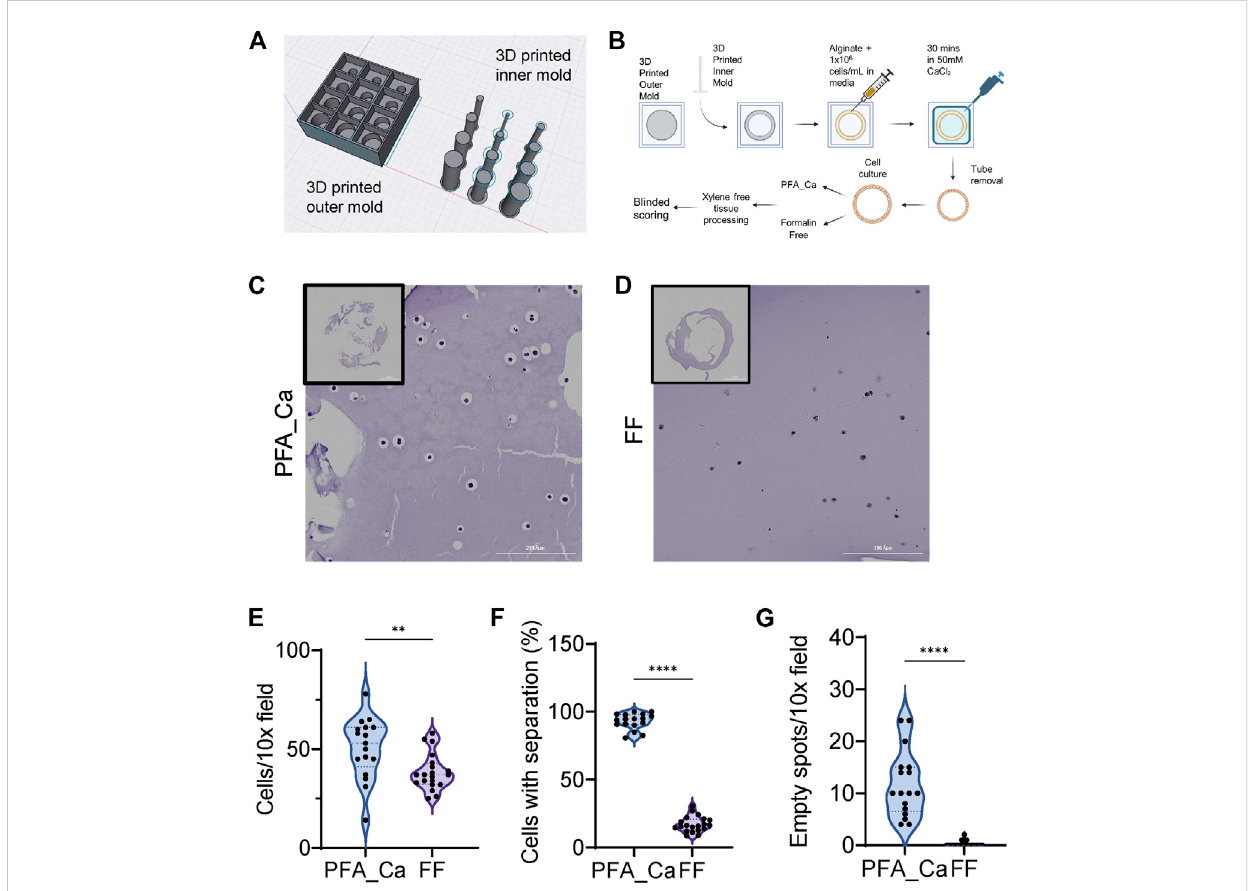
FIGURE 4 Fabrication of 3D alginate tubes containing cells using a two-part 3D printed PLA mold. (A) 3D printed mold for constructing calcium alginate tubes constructed in Sahpr3D. (B) 3D printed inner molds are placed inside the outer mold and lightly dipped in 50 mM calcium chloride solution. The inner portion of the mold is slowly fi lled with sodium alginate and cell solutions until it reaches the top of the depressed region of the mold. Next 50 mM calcium chloride solution is placed on the crosslinking reservoir above the tube and sodium alginate solutions containing cells are allowed to crosslinkfor30 min.Tubesarethencarefullyremovedandsubjectedtocellcultureovernightfollowedby fi xationinPFA_CaorFFandprocessed usinga xylene free tissue processing routine. H&E sections were then blindly scored. (C) PFA_Ca and (D) FF fi xed calcium alginate tubes. (E) Number of cells per fi eld captures with a 10X objective shows a signi fi cant reduction in the number of cells detected per fi eld with FF. (F) Percentage of cells with separation betweencellandbiomaterial. (G) Numberofemptyspotsper fi eldofviewcapturedwitha10Xobjectiveshowsasigni fi cantlyincreasednumberofempty spots in PFA_CA as compared to FF. Central tendency measures on violin plots: long dashed lines is the median while shorter dashed lines indicated quartiles. * indicates p -value < 0.05. All statistical analyses were performed using Mann-Whitney Rank Test due to the non-normality of the data. Experiments are representative of two independent experiments (N = 2) with at least three technical replicates each time (n = 3). Figure 4B made with